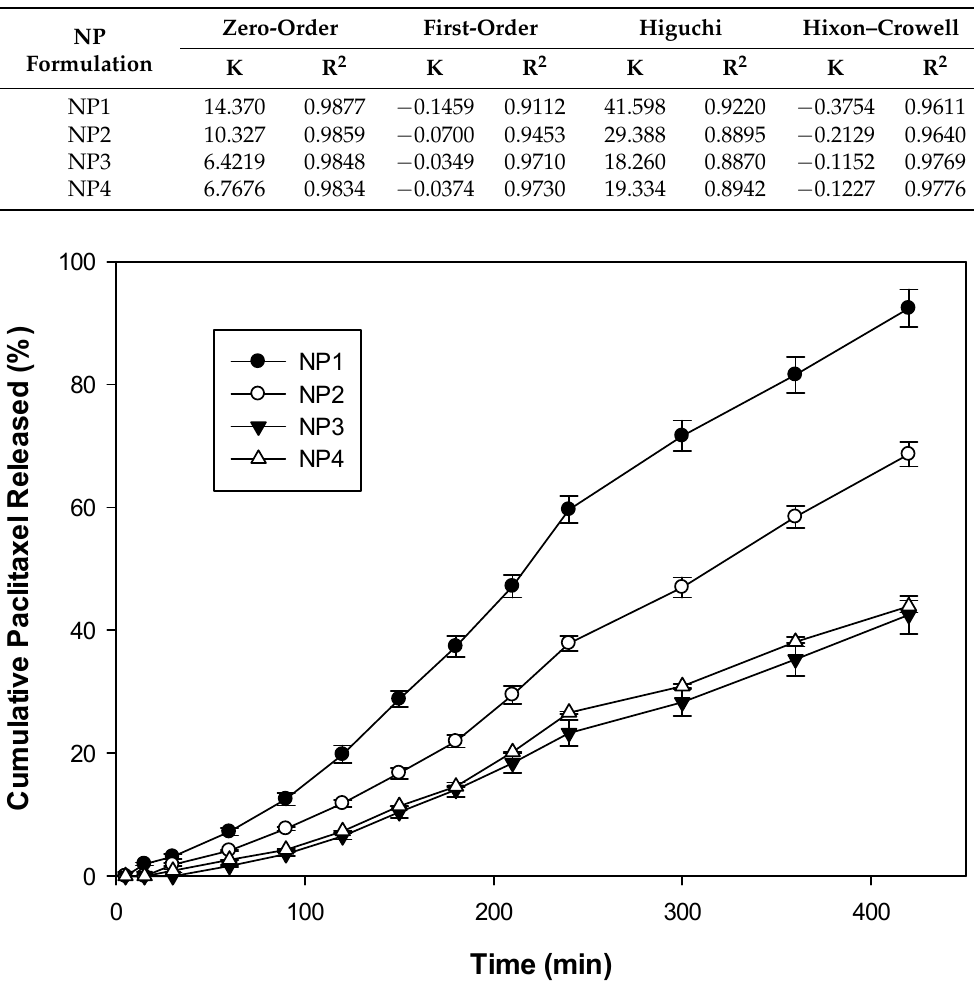
Figure 5. In vitro release profile of PTX from NPs at 37 ◦ C. Amount of PTX released was quantitatively analyzed at pH 7.4. Data are in triplicate and expressed as the mean ± standard deviation. Table 2. Release kinetics of PTX from NPs at pH 7.4.